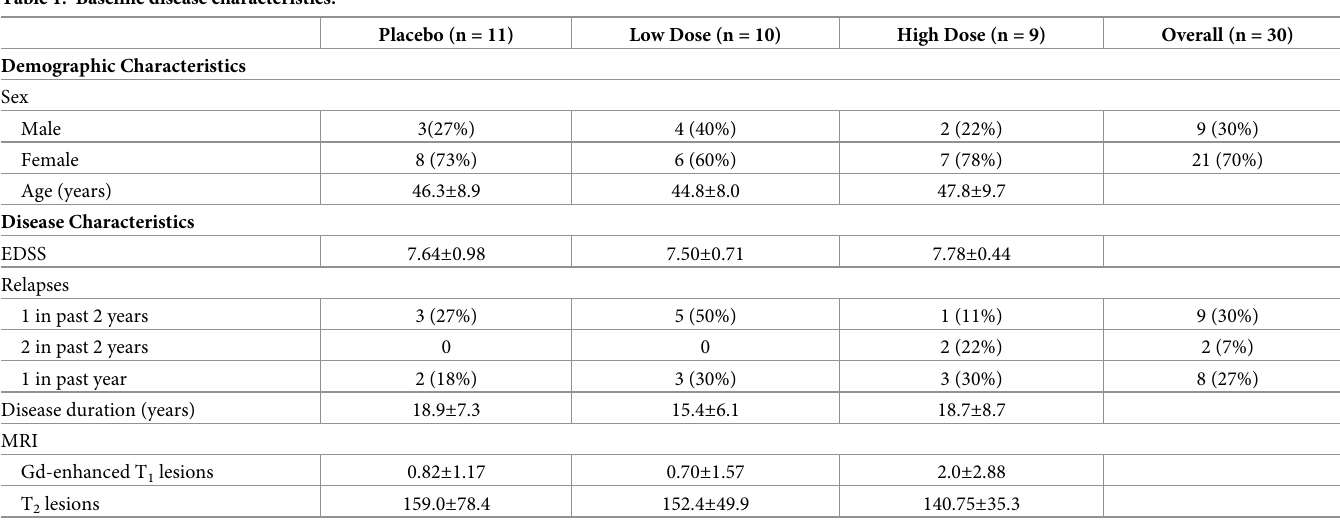
Table 1. Baseline disease characteristics.